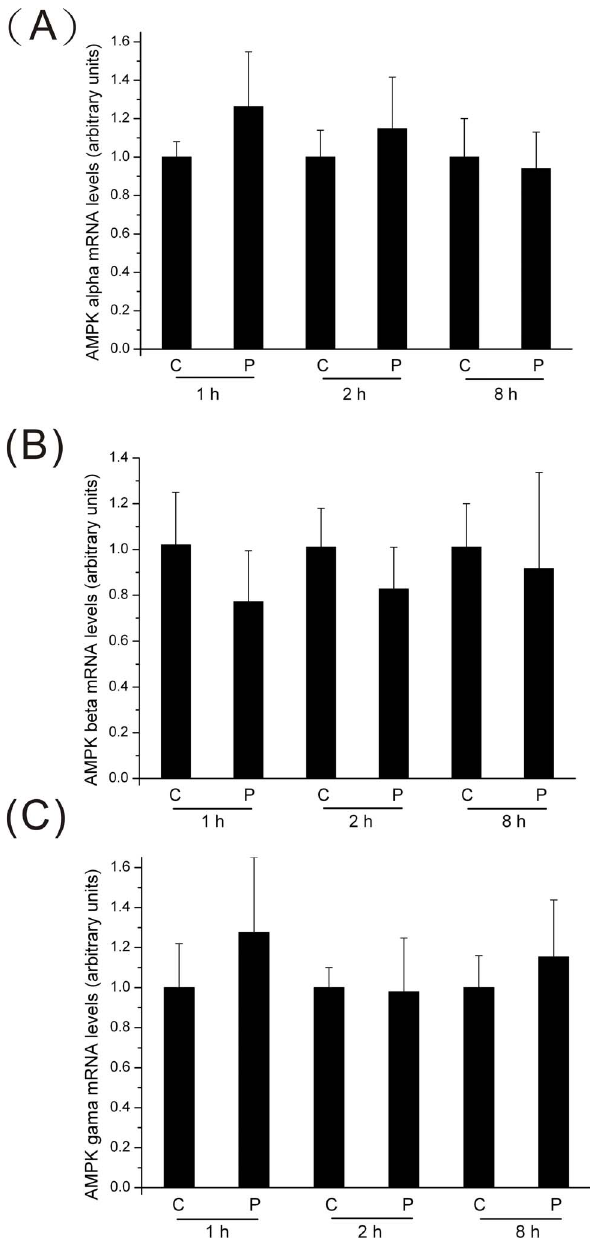
Figure 10. Changes in mRNA expression levels of AMPK a (A), b (B), and c (C) upon treatment with PTTH. Prothoracic glands from day 7 last instar larvae were preincubated in medium for 30 min, then transferred to medium containing PTTH (P) or control medium (C). The incubation was maintained for 1, 2, and 8 h. After incubation, total RNA was extracted from the prothoracic glands, and mRNA expression levels of AMPK were determined by a qRT-PCR. Each bar represents the mean 6 SEM of three separate assays.